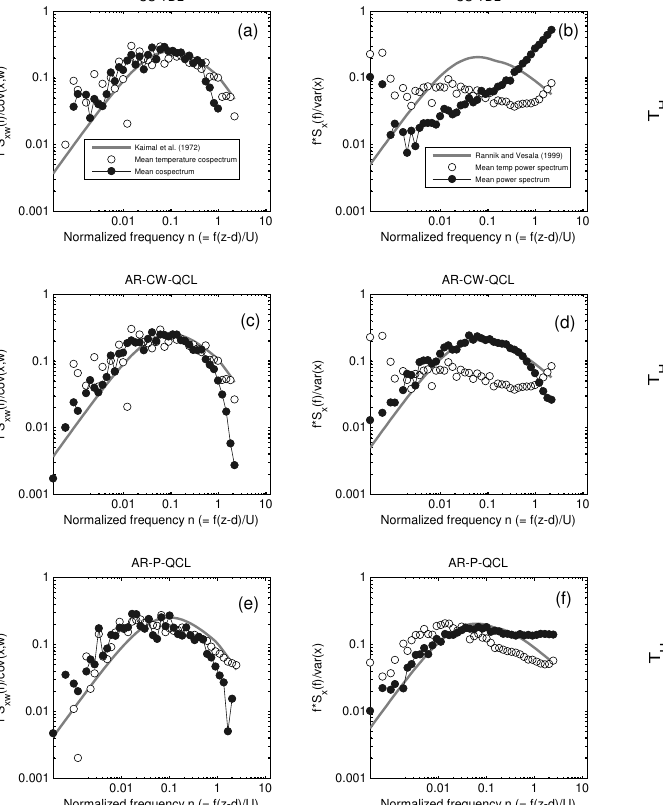
Figure 4. Co-spectral transfer functions derived for CS-TDL (a) , AR-CW-QCL (b) and AR-P-QCL (c) from the temperature and N 2 O co-spectra presented in Fig.